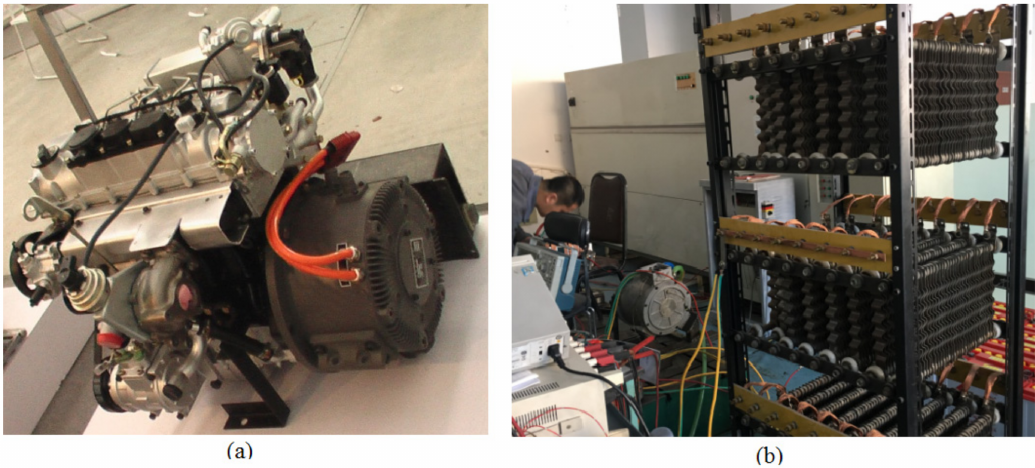
Figure 23. Large current load experiment of the integrated DC output system: ( a ) experimental platform; ( b ) load experiment.